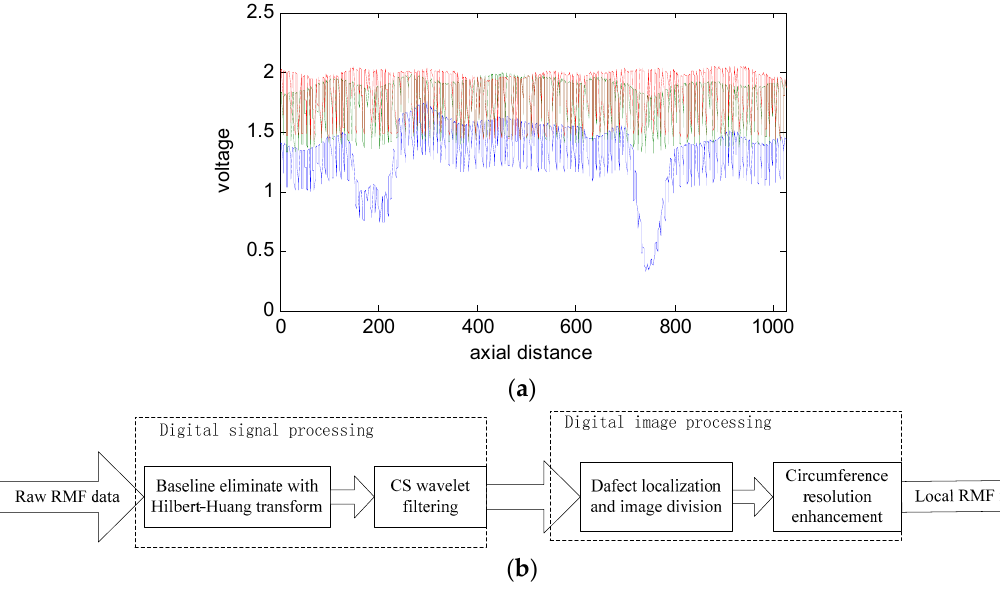
Figure 6. ( a ) One-dimensional waveforms of three channels of raw data (the data is derived from Figure 4b; ( b ) Data processing flow diagram.